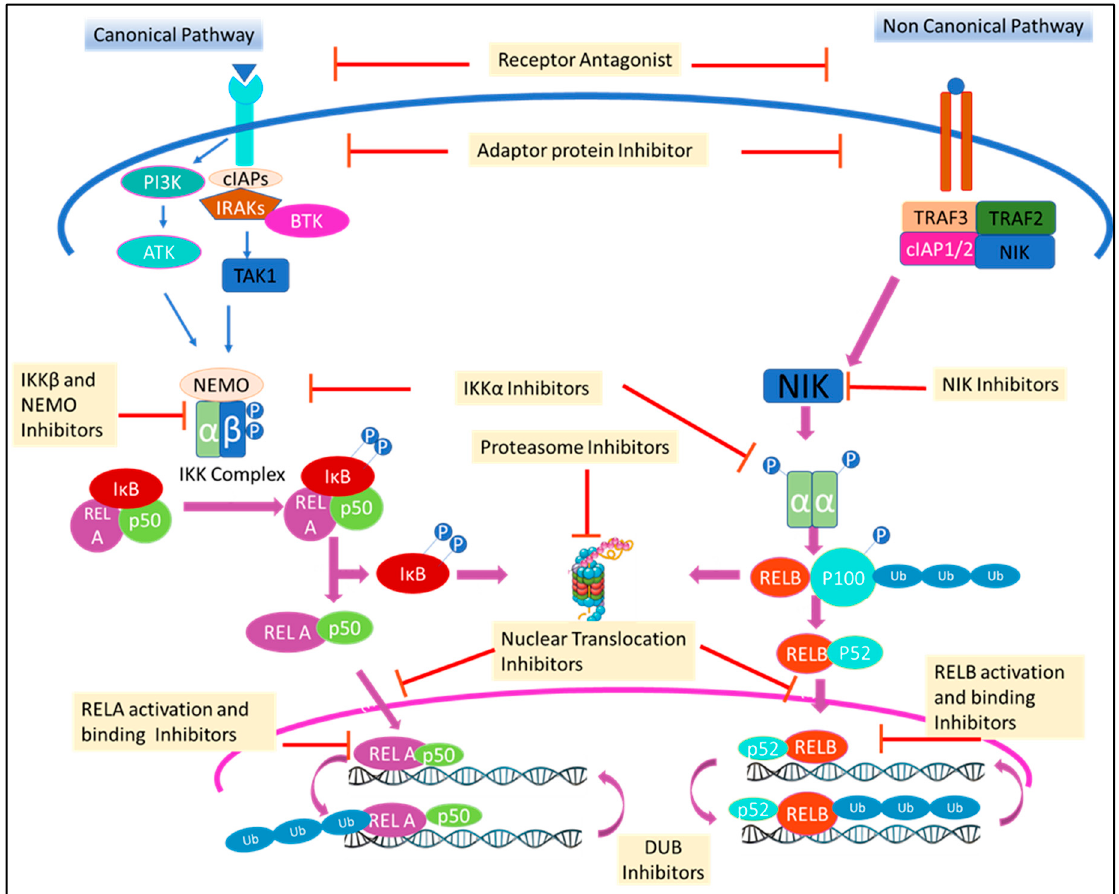
Figure 2. Canonical & non-canonical NF- κ B pathway and the site of interventions currently being explored for therapeutic benefit.